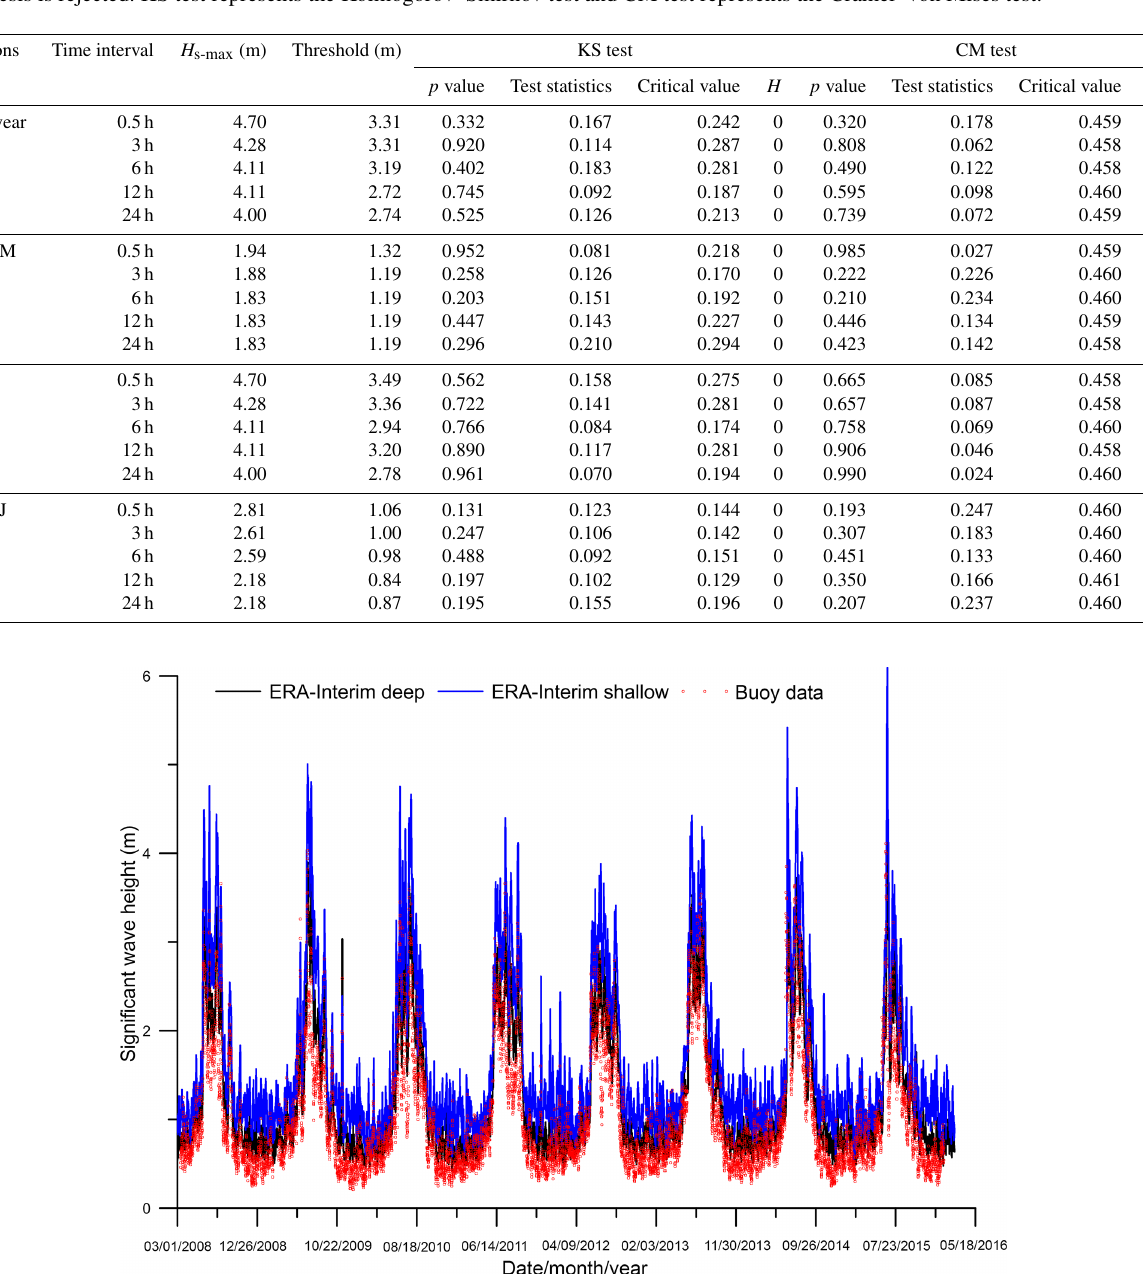
Figure 1. Time series plot of the significant wave height measured by buoy and from ERA-Interim data at shallow and deep